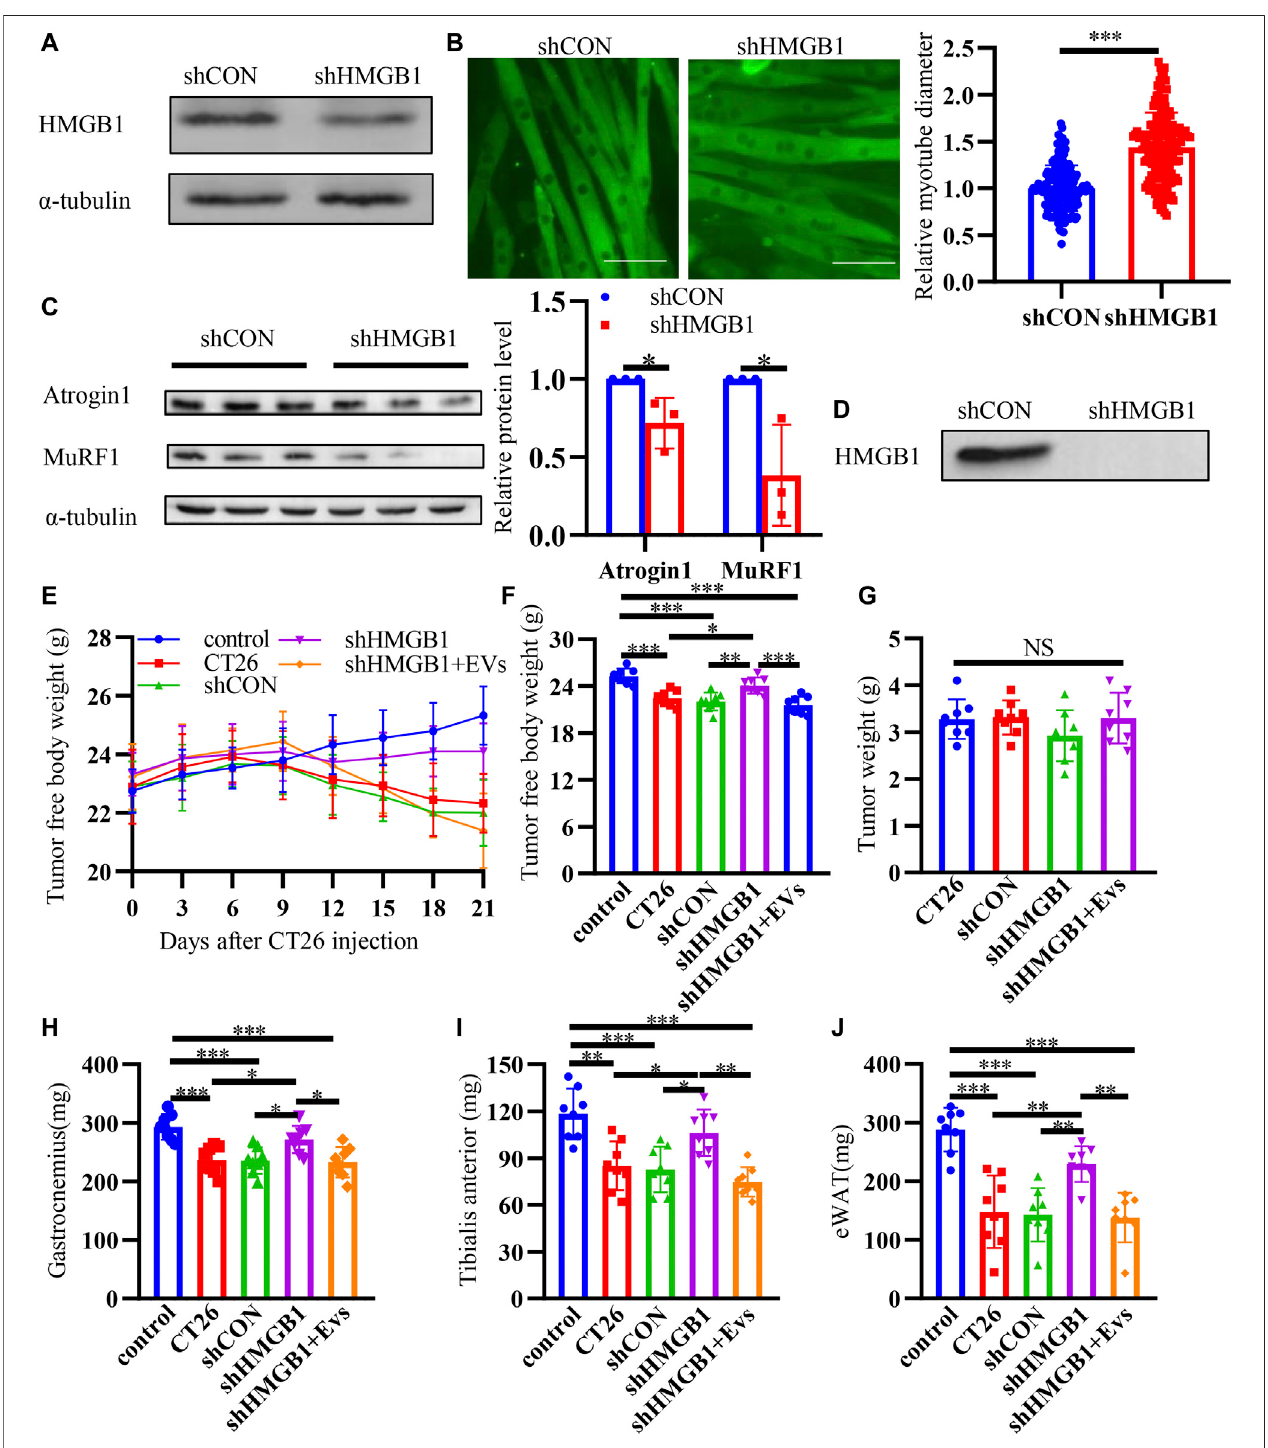
FIGURE 6 | Down regulating HMGB1 alleviates muscle wasting. (A) Decreased expression of HMGB1 was determined by western blot after knocking down of HMGB1 inCT26 celllines. (B) Representativeimmuno fl uorescence imagesforC2C12myotubestreatedwithnormalCT26-EVsand HMGB1-lowexpressedCT26-EVs. The relative fi ber widths of C2C12 myotubes treated with normal CT26-EVs and HMGB1-lowexpressed CT26-EVs. (C) Total extracts of C2C12 myotubes treated with normal CT26-EVs and HMGB1-lowexpressed CT26-EVs were used for western blotting analysis with antibodies against with Atrogin1, MuRF1 and α -tubulin. Densitometric quanti fi cation of the Atrogin1 and MuRF1 signal relative to the α -tubulin signal. (D) HMGB1-lowexpressed CT26-EVs contained low level of HMGB1 compared with normal CT26-EVs. (E) Tumor-free body weight growth curve of BALB/c mice. (F) Tumor-free body weight of BALB/c mice at 21 days of tumor implantation. Tumor weight (G) , bilateral gastrocnemius weight (H) , bilateral tibialis anterior weight (I) and bilateral epididymal weight (eWAT) (J) of BALB/c mice at 21 days of tumor implantation.